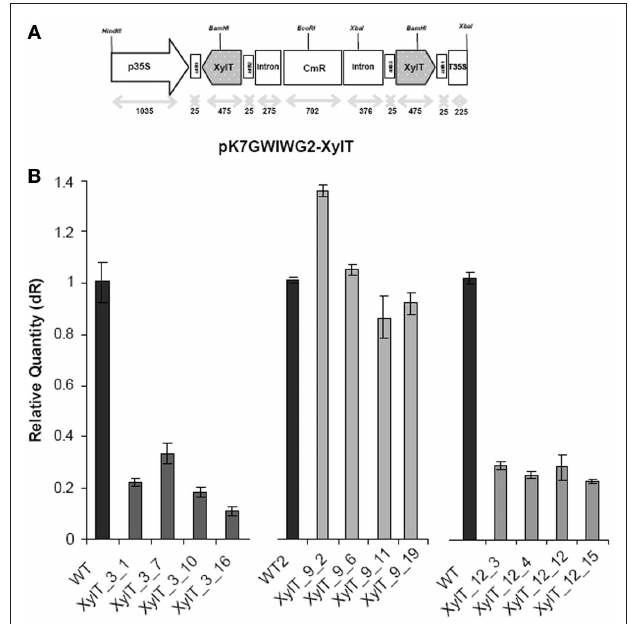
FiguRe 1 | Silencing of XylT expression in transgenic tomato plants. (A) Scheme of the XylT_RNAi construct (XylT in sense and antisense orientation). p35: 35S cauliflower mosaic virus promoter; T35S: terminator; attB1, attB2: recombination sites; CmR chloramphenicol acetyltransferase gene. (B) qPCR of three selected transgenic lines with reduced XylT expression. Total RNA of green fruits was extracted and 4 μg of total RNA were reversed transcribed. The resulting cDNA was used as template for